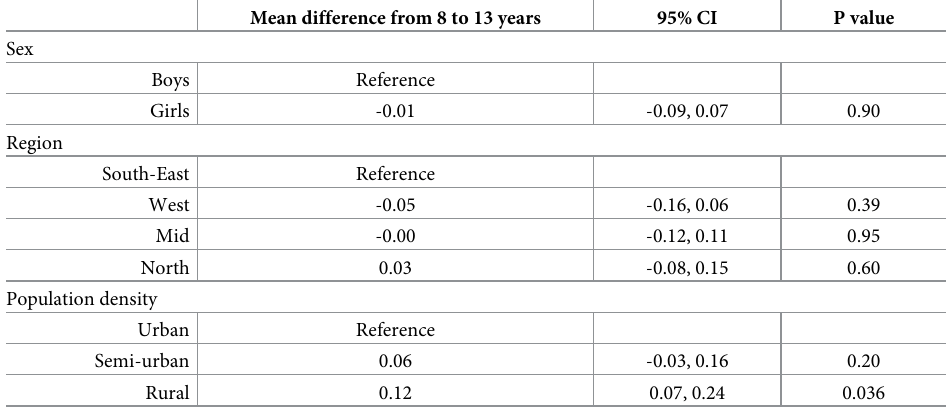
Estimated from random effect multilevel models that do not include an interaction with age and so the estimates are fixed to be the same at age 8 and 13 years. †